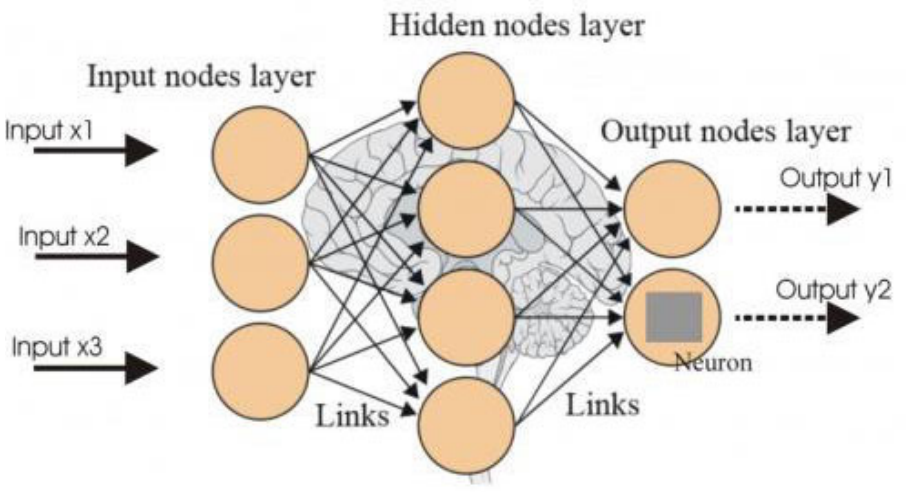
Figure 2. The structure of feed ‐ forward